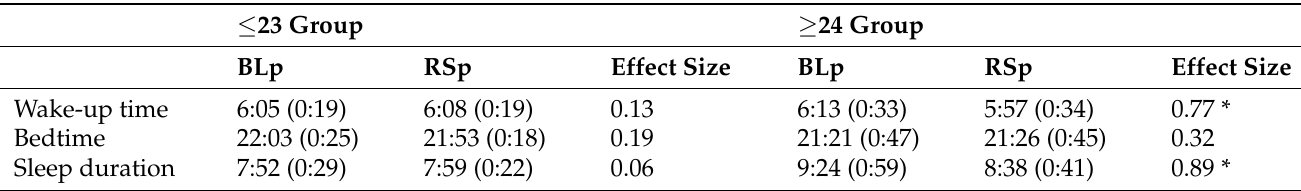
Table 3. Comparison among indices associated with sleep and the number of sensor firings between BLp and RSp in two groups.